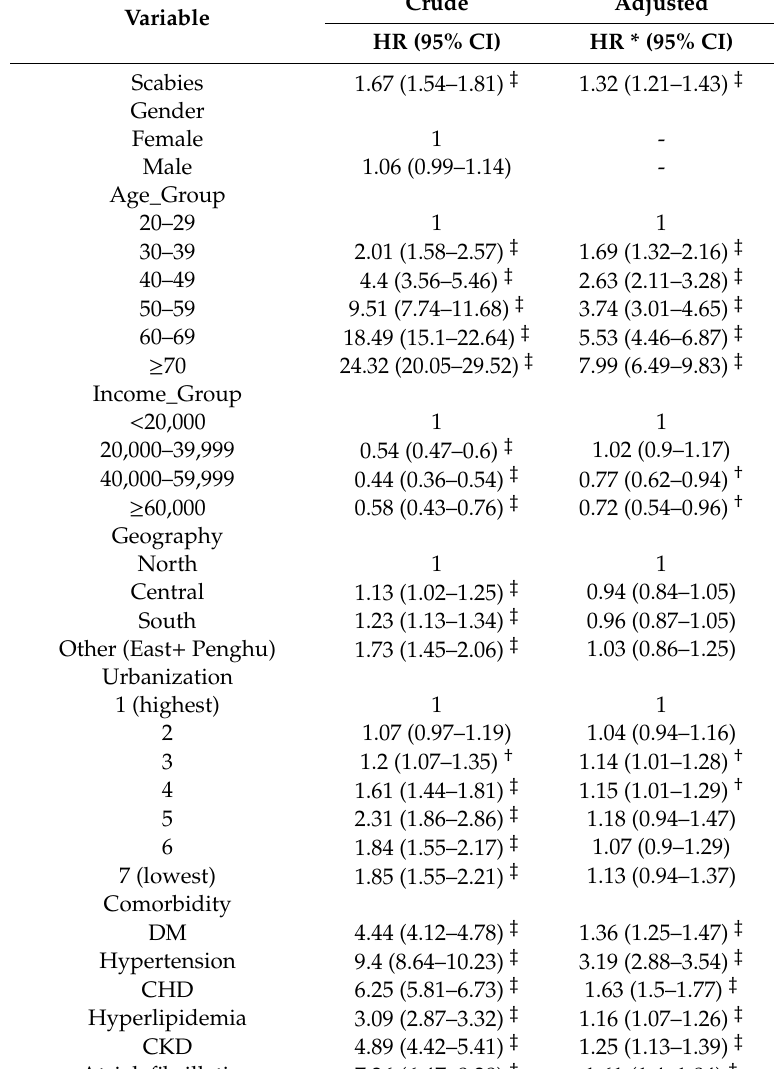
Table 3. Cox regression analysis results regarding the degree to which independent factors are predictive of